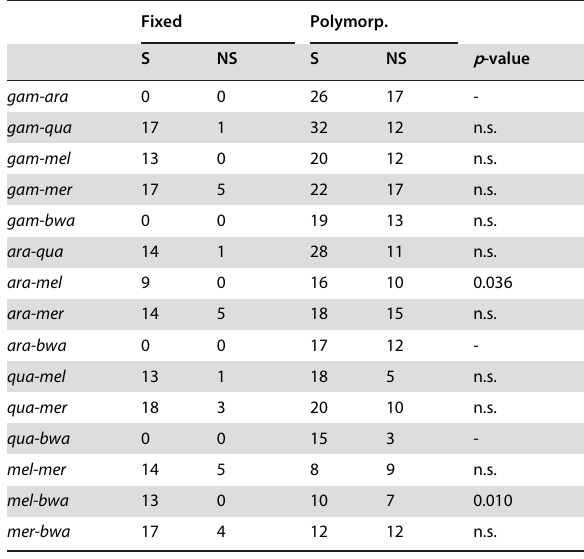
Table 3. MacDonald-Kreitman test on GNBP-B1. .. ... .... ... ... .... ... ... .... ... ... .... ... ... .... ... ... .... ... ... ....